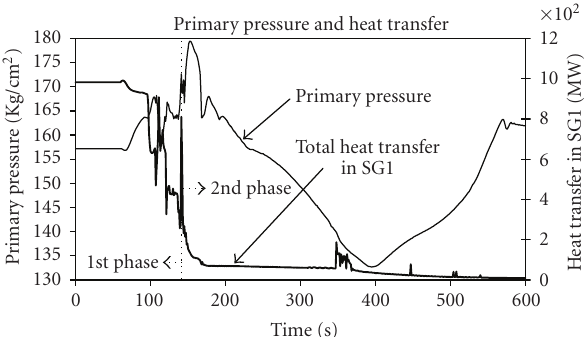
Figure 10: Heat transfer in SG1 and primary pressure (AMSAC